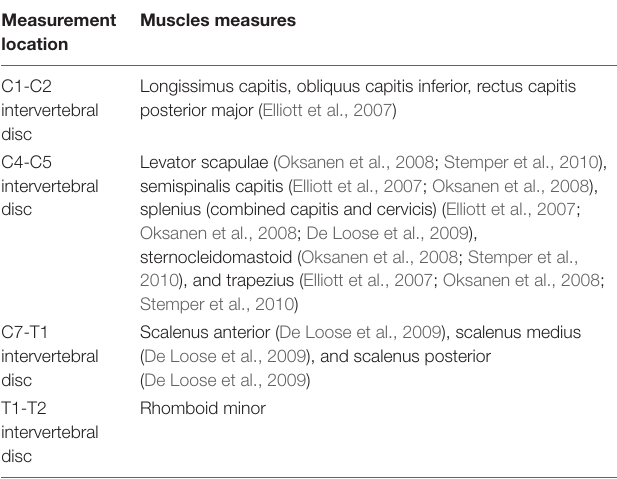
FIGURE 3 | Example of muscle fat infiltration (MFI) calculation. White outlined regions of interest represent a muscle (left semispinalis capitis) and subcutaneous fat reference used for the MFI measurement at the C4-C5 vertebral level. The resulting MFI calculation is shown, in which the mean pixel intensity (MPI) of muscle was reported as a percentage of the reference fat MPI.